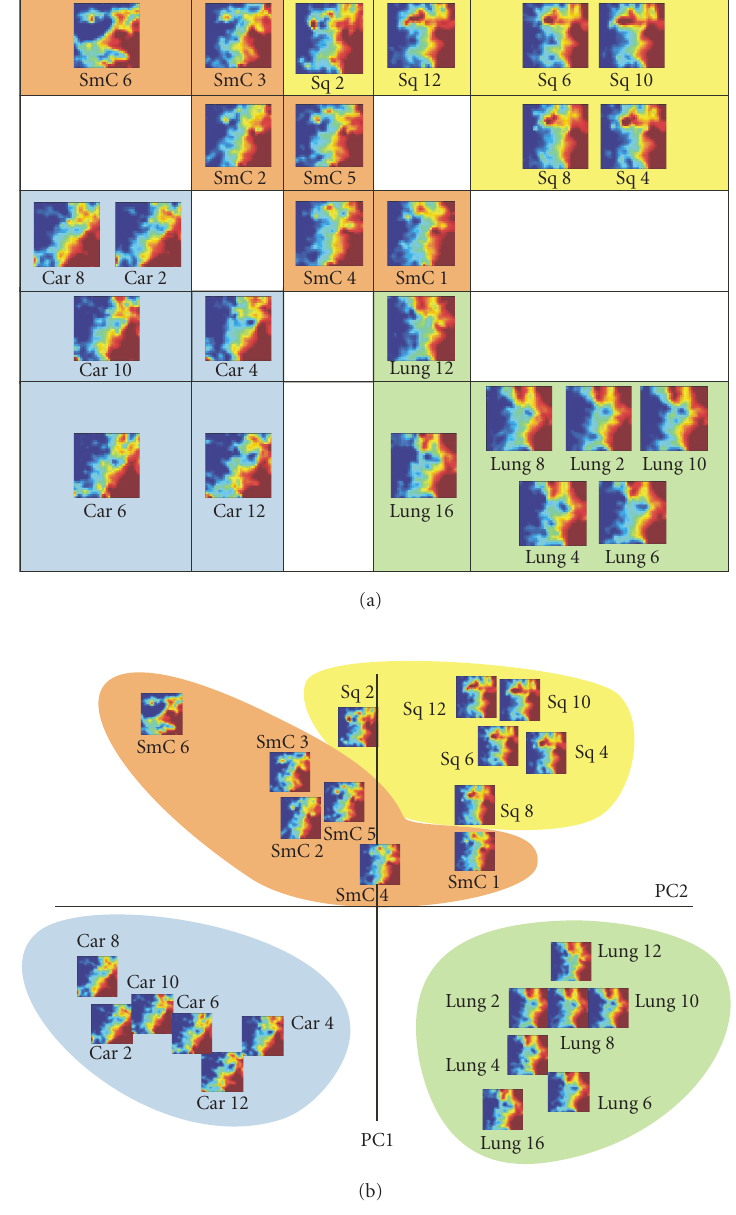
Figure 4: Grouping GEDI maps of di ff erent tissue types using a second-level GEDI. (a) The 25 di ff erent samples were assigned to a 5 × 5 SOM grid according to their metagene expression profiles using GEDI. The GEDI maps of the individual tissues are shown placed in the second-level SOM grid. Same types of tissues are grouped in the same neighborhood of the second-level map. (b) Principle component analysis. Each sample is mapped onto the plane spanned by the two first principal components (PC1 and PC2). Instead of representing a sample by a symbol, the GEDI map of each sample is shown. Note the similarity in sample position between (a) and